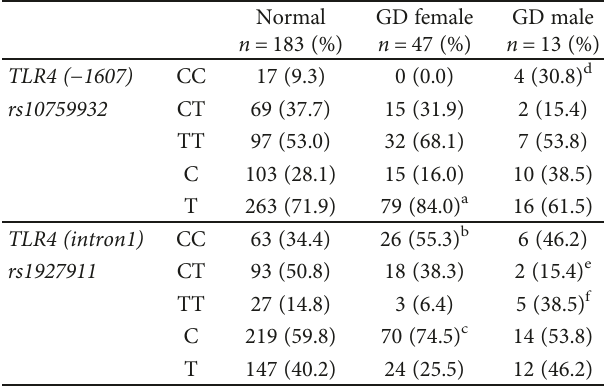
AITD: autoimmune thyroid diseases; GD: Graves ’ disease. Controls versus GD female: a OR=2.06 (1.13 – 3.74), P = 0.015, P c=0.03; b OR=2.36 (1.23 – 4.52), P = 0.008, P c=0.026; c OR= 1.96 (1.18 – 3.26), P = 0 009 , P c =0.018; controls versus GD male: d OR= 4.34 (1.21 – 15.60), P = 0 031 ; e